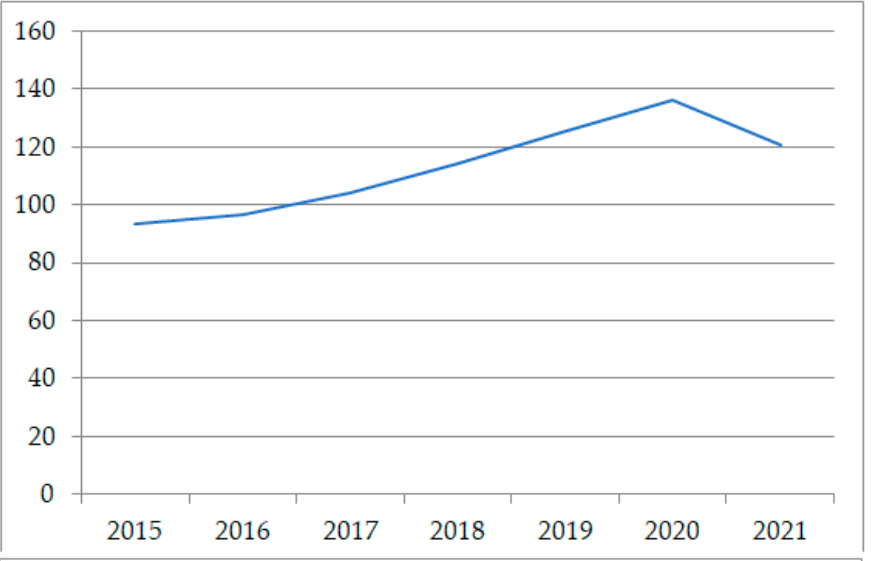
Figure 30. Net electricity production for electricity supply from 2015 to 2021 (Kwh). [77].